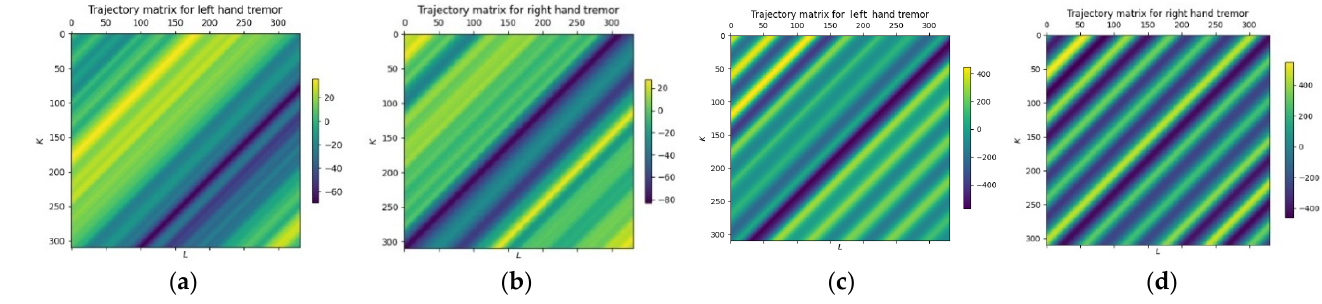
Figure 2. The trajectory matrices of tremorograms time series: ( a ) X1, patient without any pathology detected, left arm; ( b ) X2, patient without any pathology detected, right arm; ( c ) X3, patient with CNS pathology, left arm; and ( d ) X4, patient with CNS pathology, right arm. The ranks d of the trajectory matrices are equal to the length of the window L: Rank X1 = Rank X2 = Rank X3 = Rank X4 = 310.